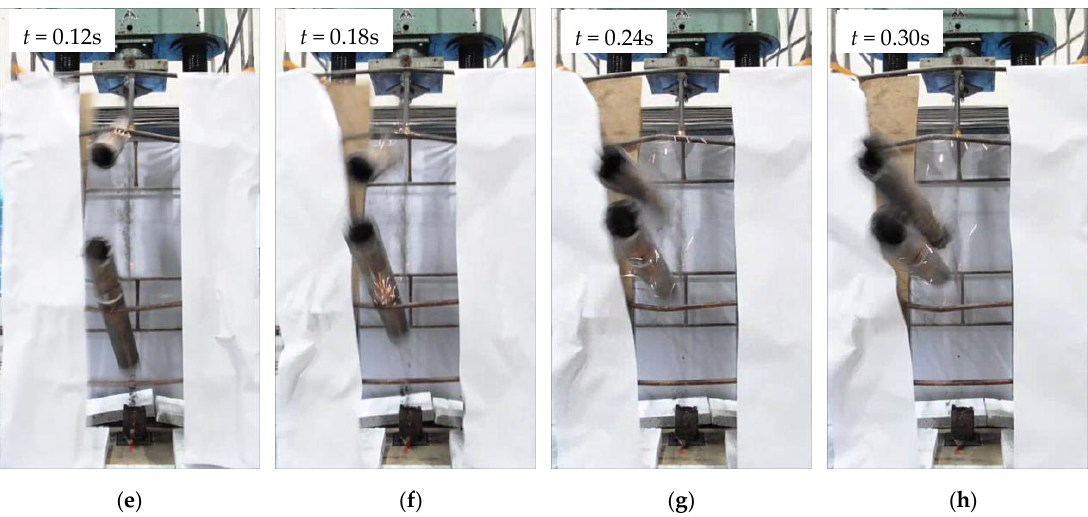
Figure 10. Course of the final stage of the test: ( a ) 0, ( b ) 0.03 s, ( c ) 0.06 s, ( d ) 0.09 s, ( e ) 0.12 s, ( f ) 0.18 s, ( g ) 0.24 s, ( h ) 0.30 s. after occurrence of the first crack (with yellow arrows locations of the subsequent cracks have been marked).